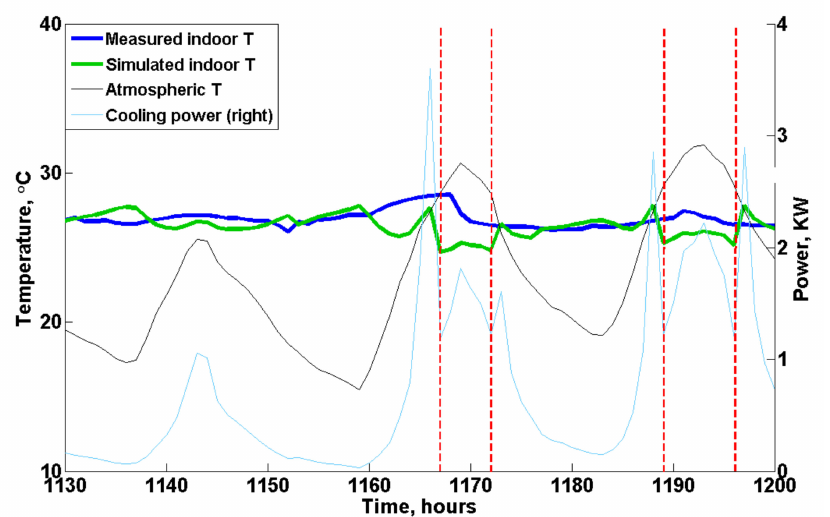
Figure 11. An example of the effect of evaporative cooling on the indoor temperature. The red dashed line indicates the activation of evaporative cooling in the customized model. Note: The base ventilation is not included in the